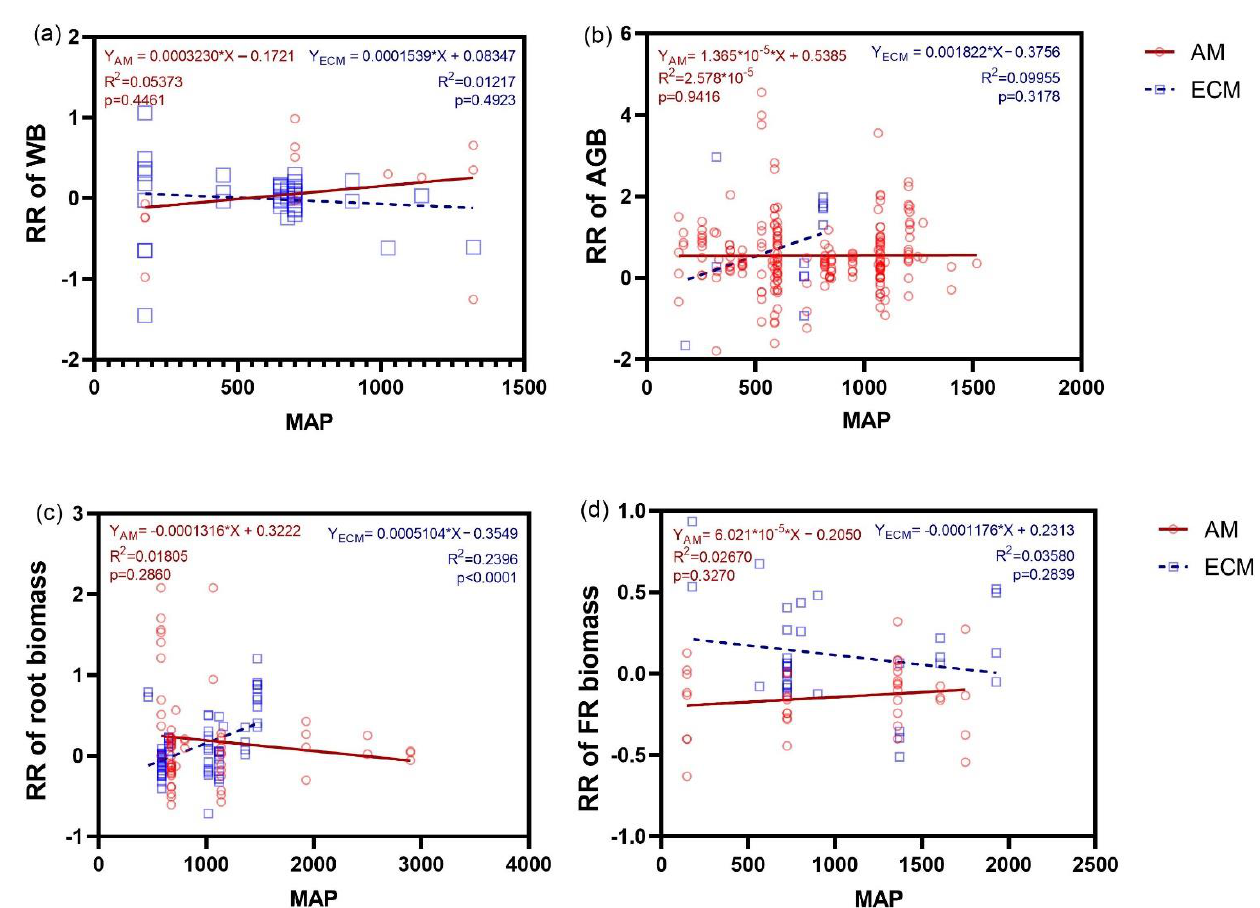
Figure 7. Relationship between the ratio response (RR) of WB ( a ), AGB ( b ), the biomass of root ( c ) and FR ( d ), and changes of MAP (Mean annual precipitation) under N addition between AM and ECM plants. Each point in the figure represents a different observation. AM, arbuscular mycorrhiza; ECM, ectomycorrhiza; WB, whole plant biomass; AGB, aboveground biomass; FR, fine root.